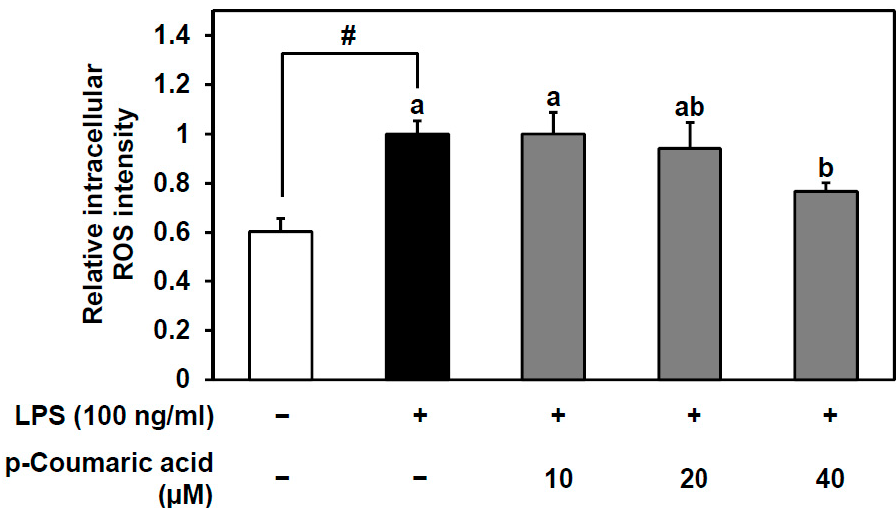
Figure 5. Antioxidant effect of p-coumaric acid on LPS-induced intracellular reactive oxygen species (ROS). After pretreatment with 10, 20, and 40 µM p-coumaric acid for 1 h, HUVECs were stimulated with LPS for 3 h. Relative intracellular ROS was measured using the cell-permeable fluorogenic probe 2 ′ ,7 ′ -dichlorofluorescin diacetate (DCF-DA) as described in the Materials and Methods. Data are expressed as mean ± SD ( n = 3). Student’s t -test was used for statistical analysis between control and LPS treatment; # ( p < 0.05). Data were analyzed using one-way analysis of variance (ANOVA) followed by Tukey’s honest significant difference test. Different letters (a and b) indicate significant differences ( p < 0.05) among samples treatments with LPS; +, treated with LPS or p-coumaric acid, − , not treated with LPS or p-coumaric acid.